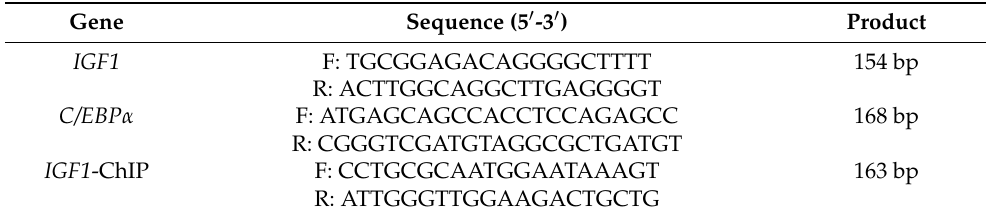
Table 2. Primers used for